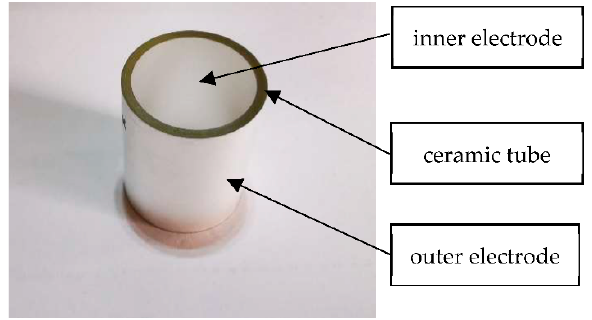
Figure 3. The PZT-52 tube actuator with continuous electrode.